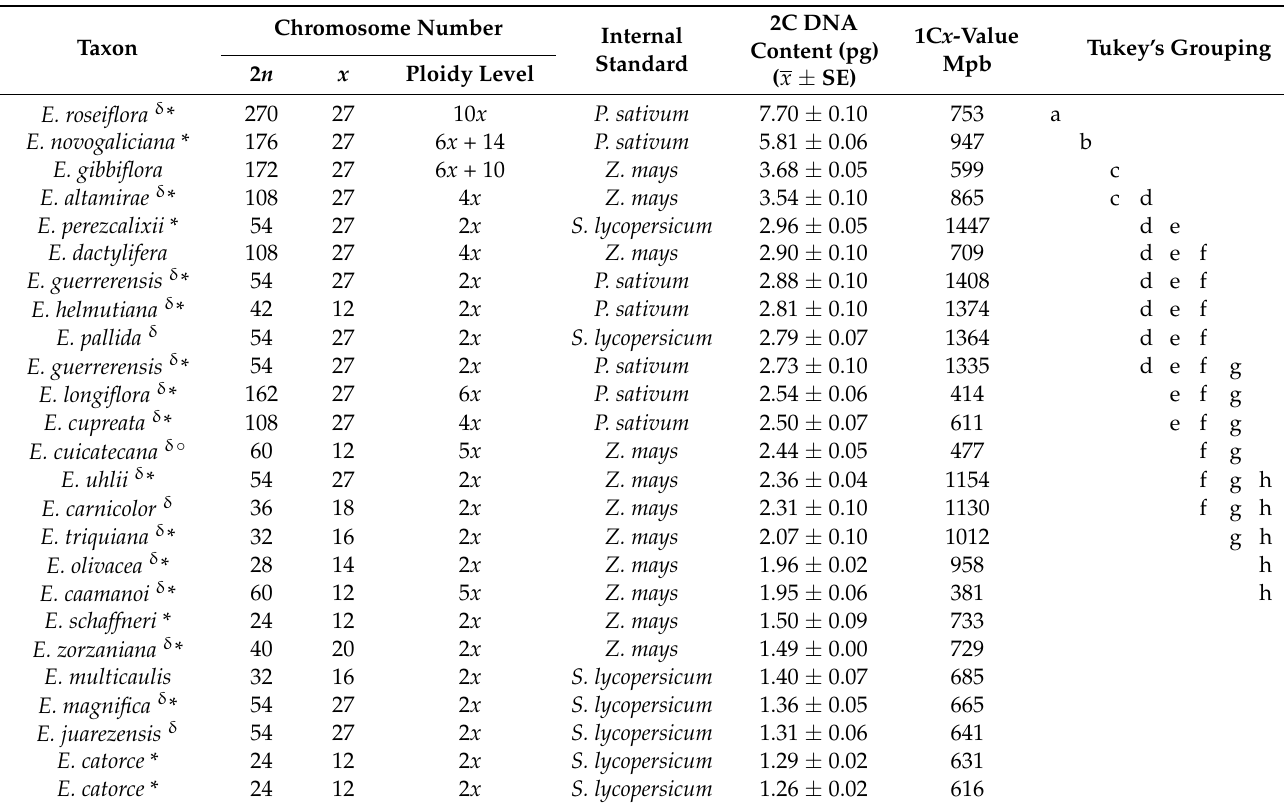
Table 2. Chromosome number, ploidy level, internal standards used and genome size, and 2C DNA Tukey-Kramer test of species of Echeveria